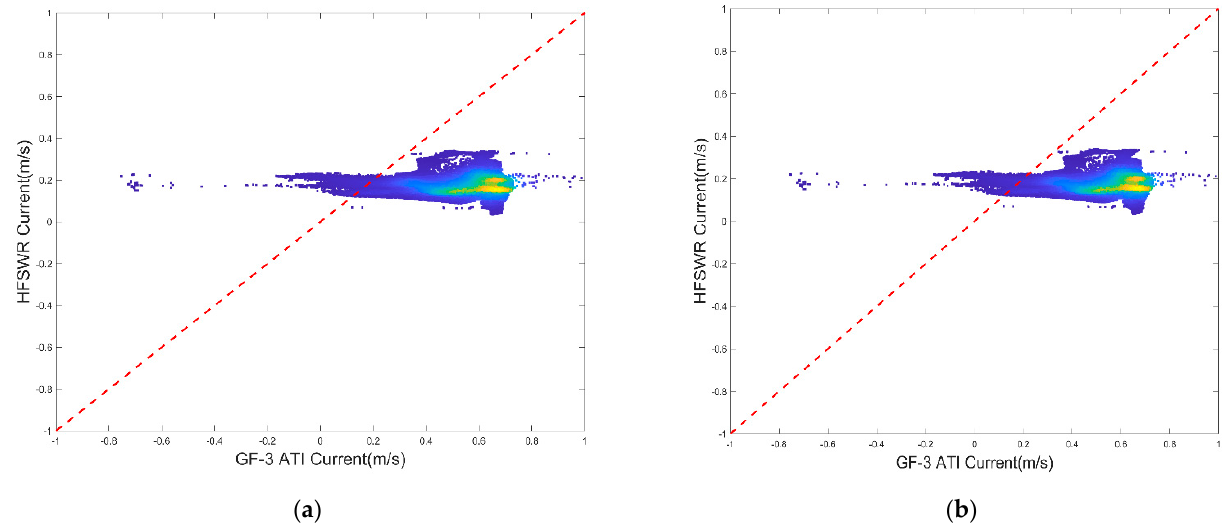
Figure 13. Scatter diagrams of GF − 3 ATI currents processed with the ECWMF wind field versus the HFSWR data for the two scenes: ( a ) represents scene b; ( b ) represents scenes c in the figure 1.